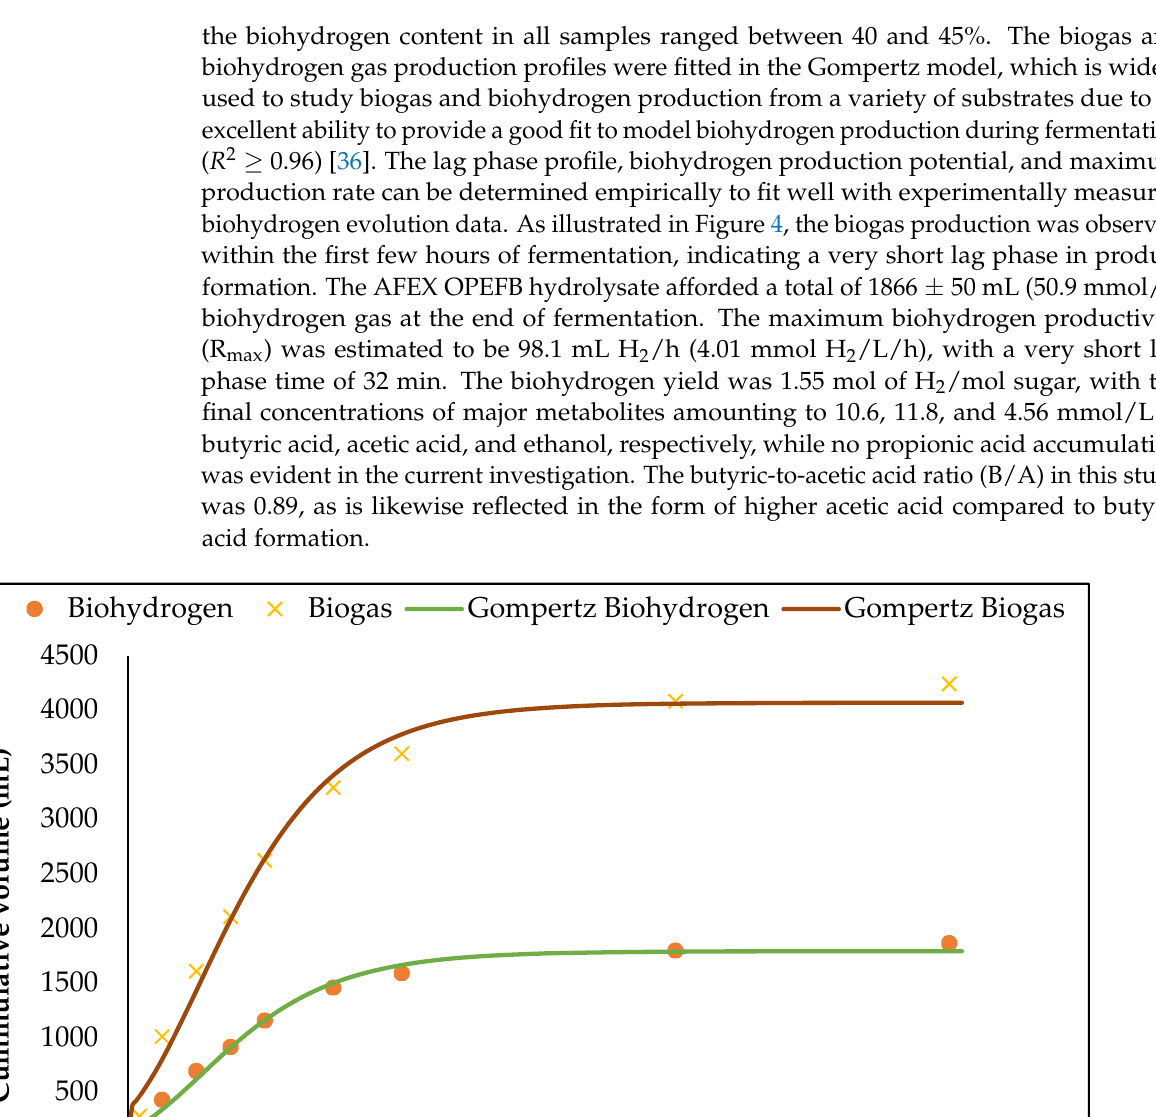
15 of 19 Table 3. Summary of major sugar and soluble compounds in AFEX OPEFB hydrolysate and DAA OPEFB molasses. Soluble Compounds